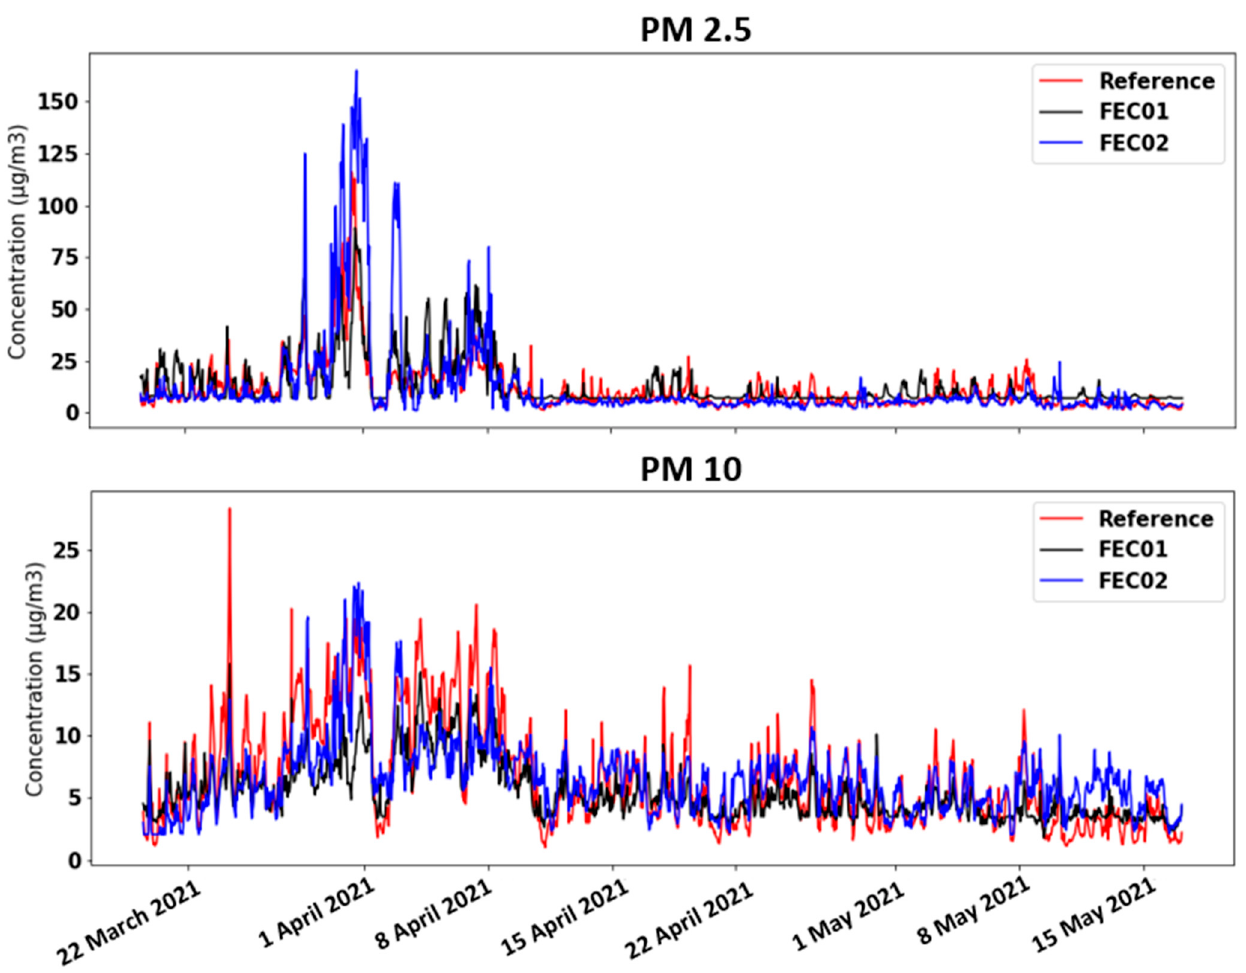
Figure 8. Time chart of PM 10 and PM 2.5 concentrations obtained with MLP calibration technique.